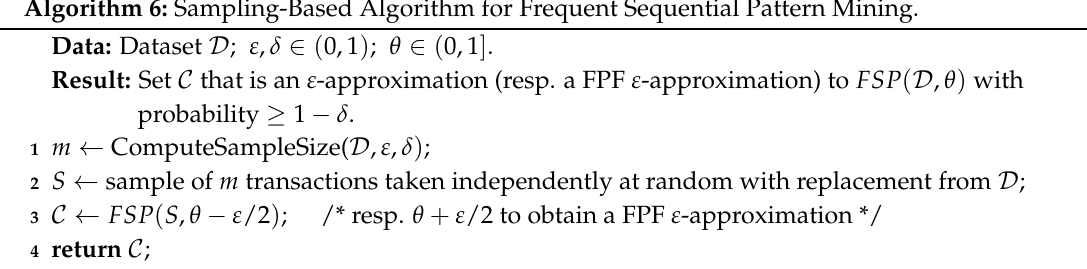
Algorithm 6: Sampling-Based Algorithm for Frequent Sequential Pattern Mining.